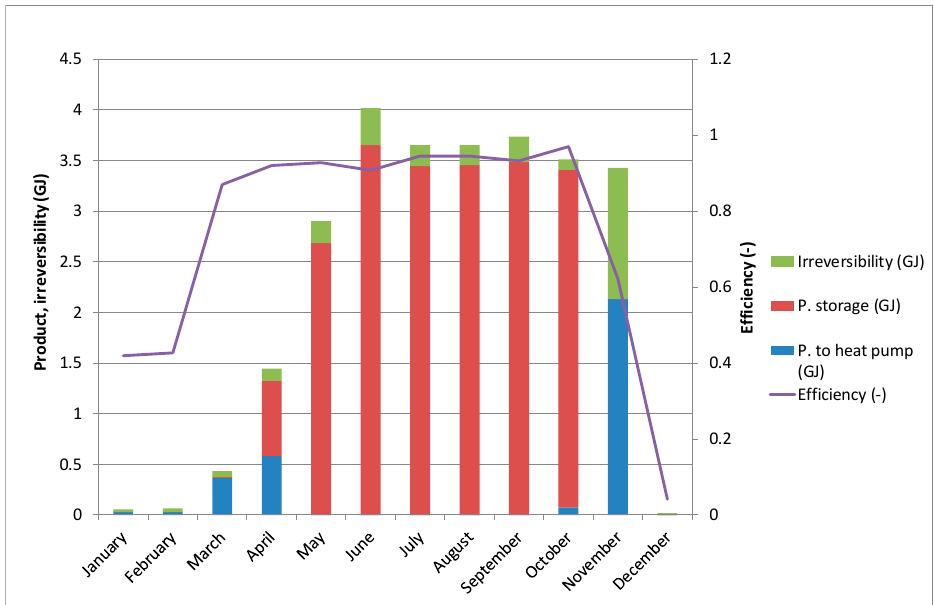
Figure 9. Seasonal storage: Fuel.